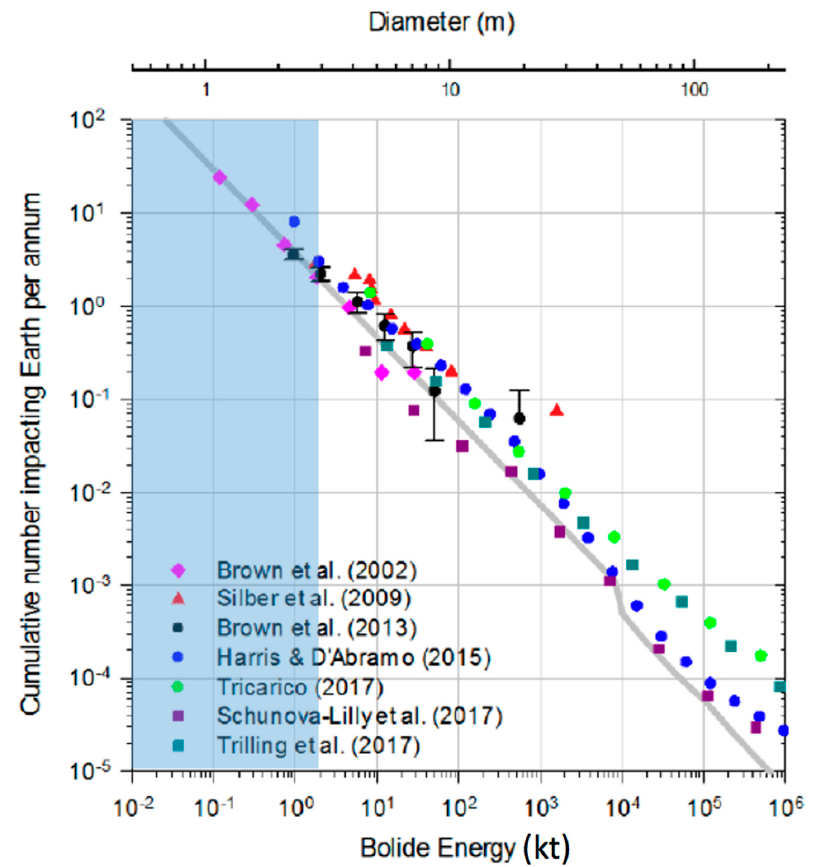
Figure 3. Impact frequency over mean impact energy (and estimated diameter). The grey line represents a fit through actually recorded bolide events presented in several publications (see legend) based on several sensor systems. The light blue shaded area is the expected detection range of GLM and it complements the available data towards smaller sizes [27].